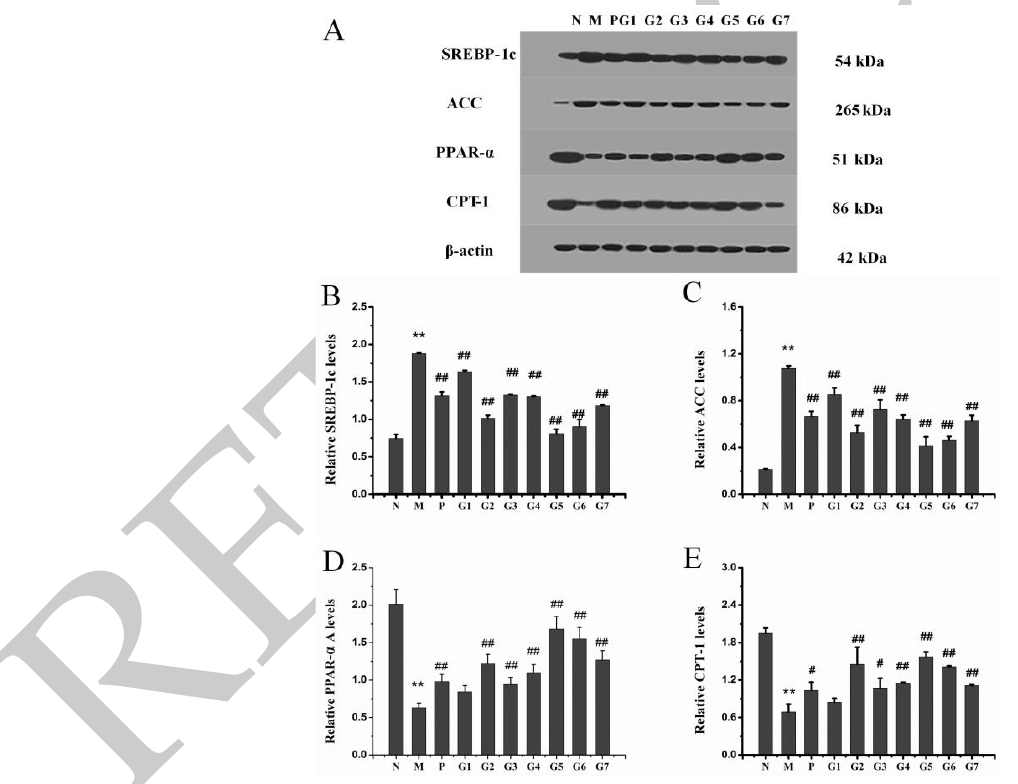
Figure 7. Hepatic protein expression of SREBP-1c, ACC, PPAR- α and CPT-1a in ALD rats. ( A ) Western blot of SREBP-1c, ACC, PPAR- α and CPT-1a and ( B – E ) semi-quantitative analysis of these proteins. N: normal group, M: model group, P: silybin positive group, G1: 18α-GA:18β-GA = 10:0, G2: